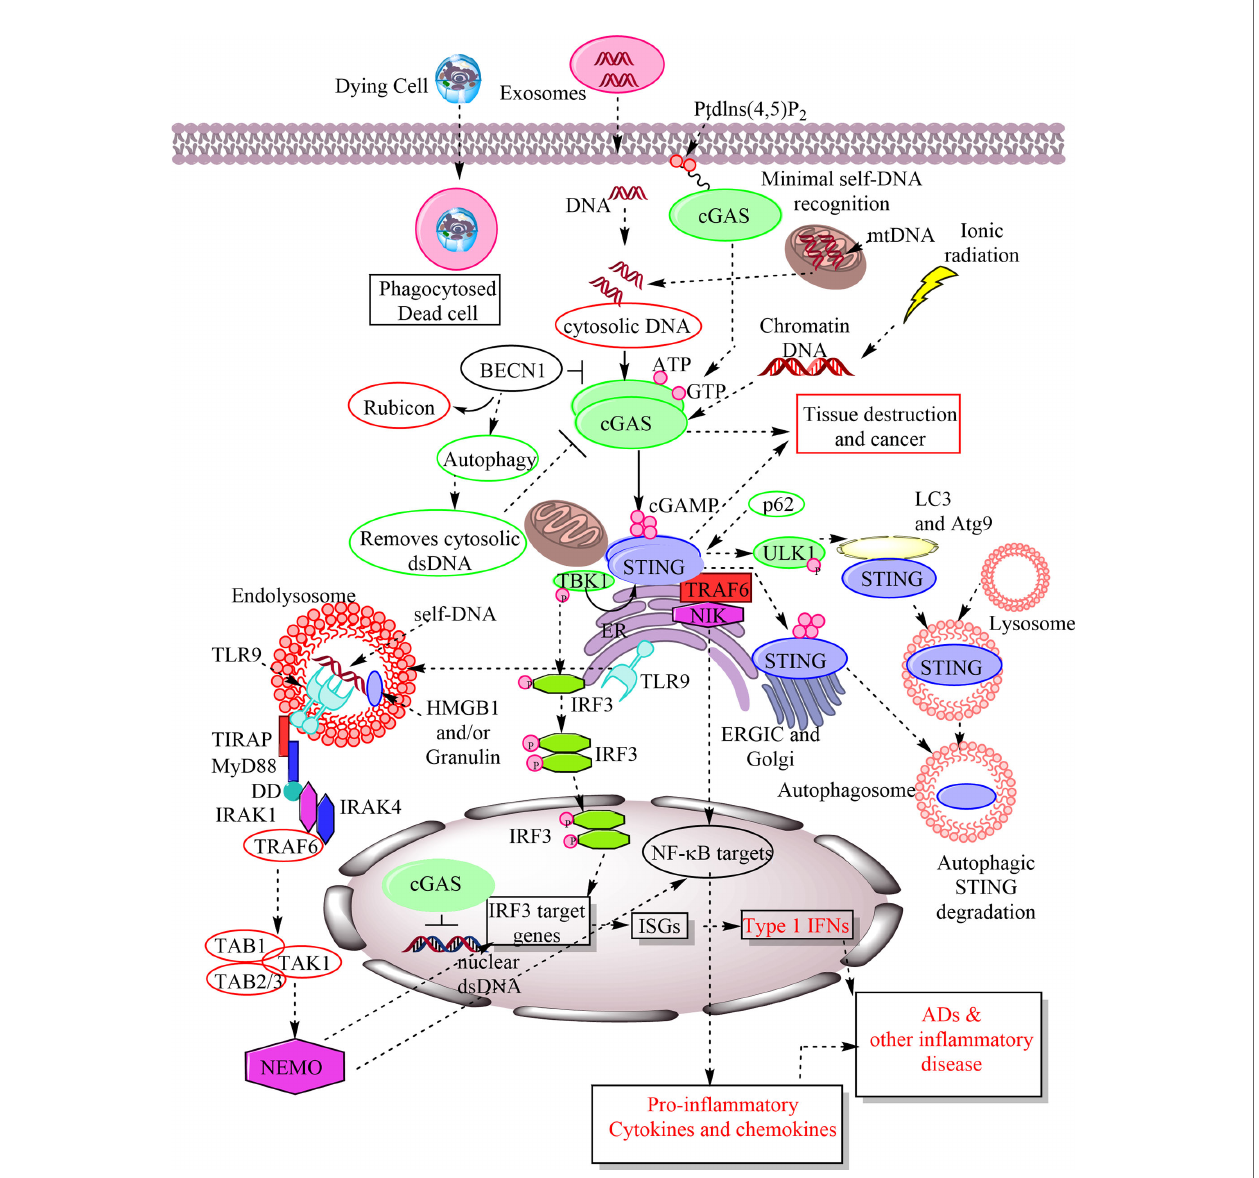
FIGURE 1 | Schematic representation of cGAS-STING and TLR9 signaling in response to the recognition of host-derived self-DNA as a DAMP. The entry of the self- DNA in the cytosol due to mitochondrial damage, nuclear damage, exosome-derived DNA, and the phagocytosis of dead cell does not remain as hidden from cytosolic PRRs. The cGAS identi fi es them as a potent DAMP in the cytosol and catalyze the cGAMP formation. The cellular exposure to the ionic radiations also induces cytosolic levels of chromatin DNA, which is also recognized by cGAS as a DAMP. The cGAMP is recognized by downstream signaling molecule called STING located in ER. STING activation phosphorylates TBK1 that further activates or phosphorylates IRF3. IRF3 stimulates IRF3 target genes, including ISGs, which also include type 1 IFN. Also, STING activation activates NF- k B target pro-in fl ammatory genes for cytokines and chemokines. Hence, cGAS-STING signaling plays a crucial role in in fl ammation, cancer, auto-in fl ammation and ADs. The cGAMP recognition by STING also induces its autophagosome-mediated degradation. The p62 is an endogenous negative regulator of the STING and induces its autophagic degradation. BECN1 is also an endogenous cGAS inhibitor and their interaction removes Rubicon (an autophagy inhibitor) from the BECN1 that induces autophagy to remove cytosolic DNA. Hence, autophagy serves to remove cytosolic DNA without inducing in fl ammatory damage. Failure of autophagy increases in fl ammatory recognition of cytosolic DNAs by different cytosolic PRRs. On the other hand TLR9 is present in the ER during resting stages as soon as cytosolic CpG DNAs or host DNA enter into the endosome or endolysosomes TLR9 also migrates there and recognizes them as a crucial DAMP. TLR9 activation induces MyD88-dependent downstream signaling pathway to activate IRF3-based type 1 IFN production and NF- k B-mediated pro-in fl ammatory cytokine generation to cause in fl ammation and in fl ammatory diseases. MyD88 has a TIR domain and death domain (DD). The TIR domain of MyD88 activates interleukin-1 receptor-associated kinase-4 (IRAK-4) and IRAK-1. IRAK-4 subsequently recruits TRAF6 to activate transforming growth factor- b associated kinase 1 (TAK1). TAK1 is linked to TRAF6 via TAB2 adaptor protein, whereas TAB1 adaptor protein interacts constitutively with TAK1 and induces TAK1 kinase activity. TAK1 then phosphorylates I k B kinase (IKK) complex through K63-linked ubiquitination of NEMO (NF- k B essential modulator), an I k B kinase regulatory subunit that is critical for the NF- k B, IRF3, and MAPK